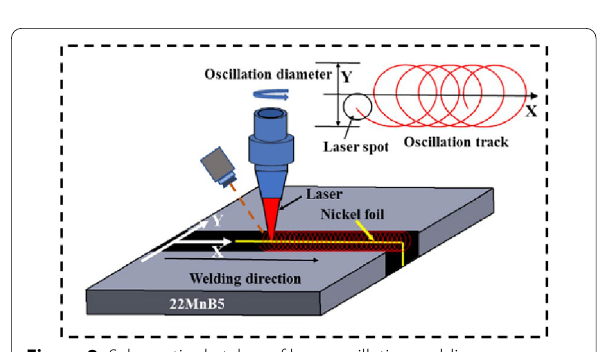
Figure 2 Schematic sketches of laser oscillation